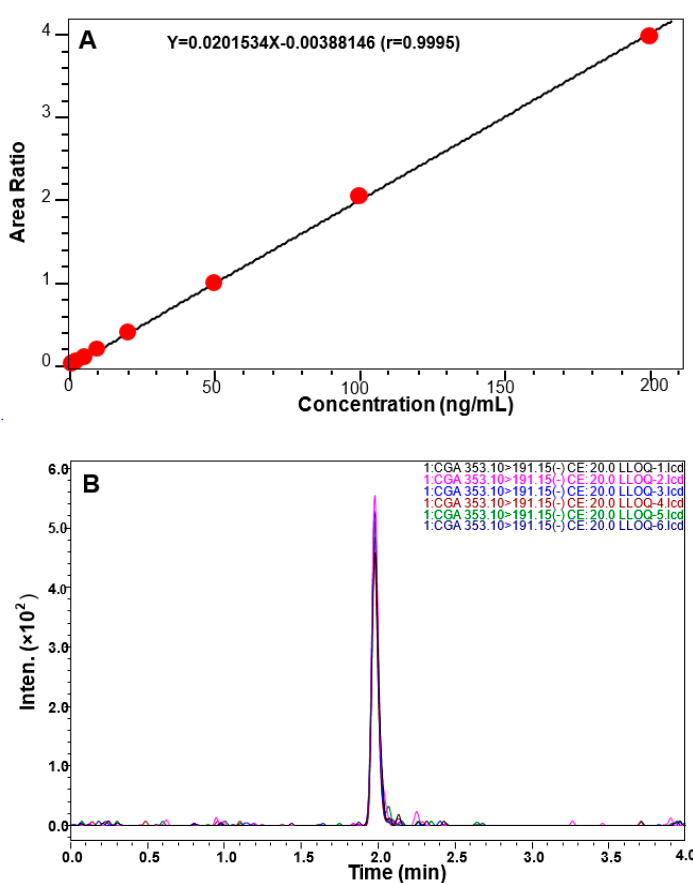
Figure 9. Linear regression calibration curves of CGA ( A ) and the six consecutive MRM of blank CSF spiked with 0.5 ng/mL CGA ( B ) in the CSF of